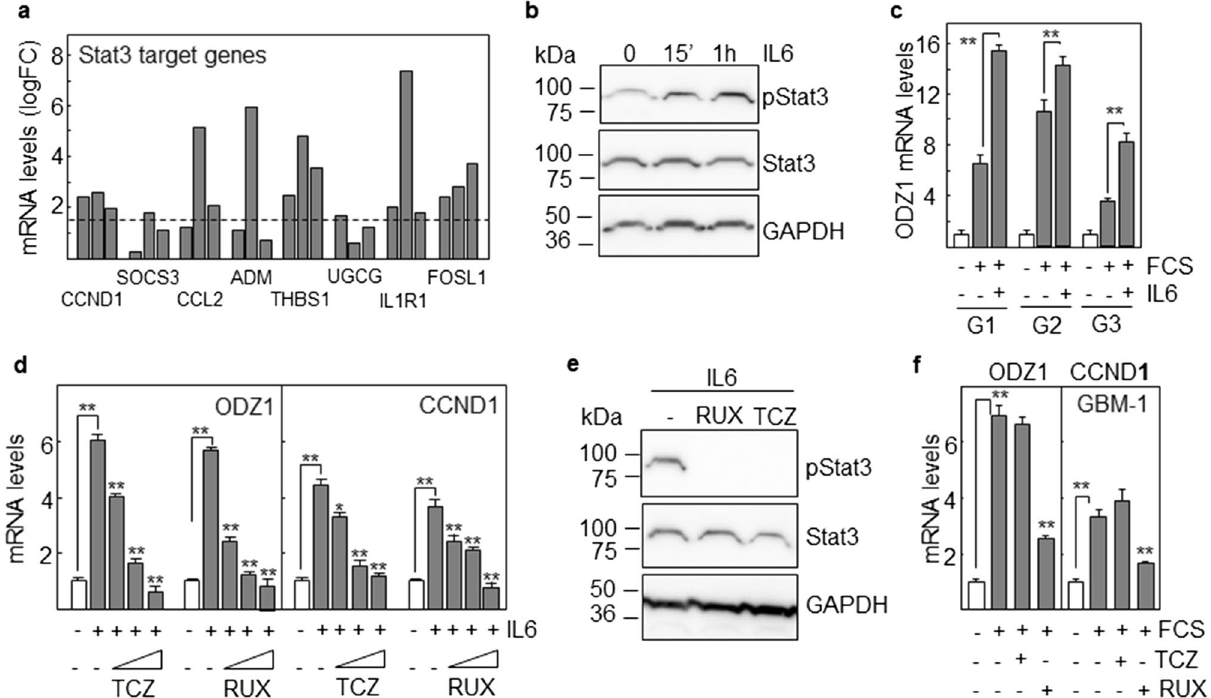
fold-change (FC) in gene expression of GBM cells incubated with 10% FCS relative to cells without FCS in three different cultures. Differences were selected as significant using a logFC cut-off of 1.5 (dotted line). ( b )